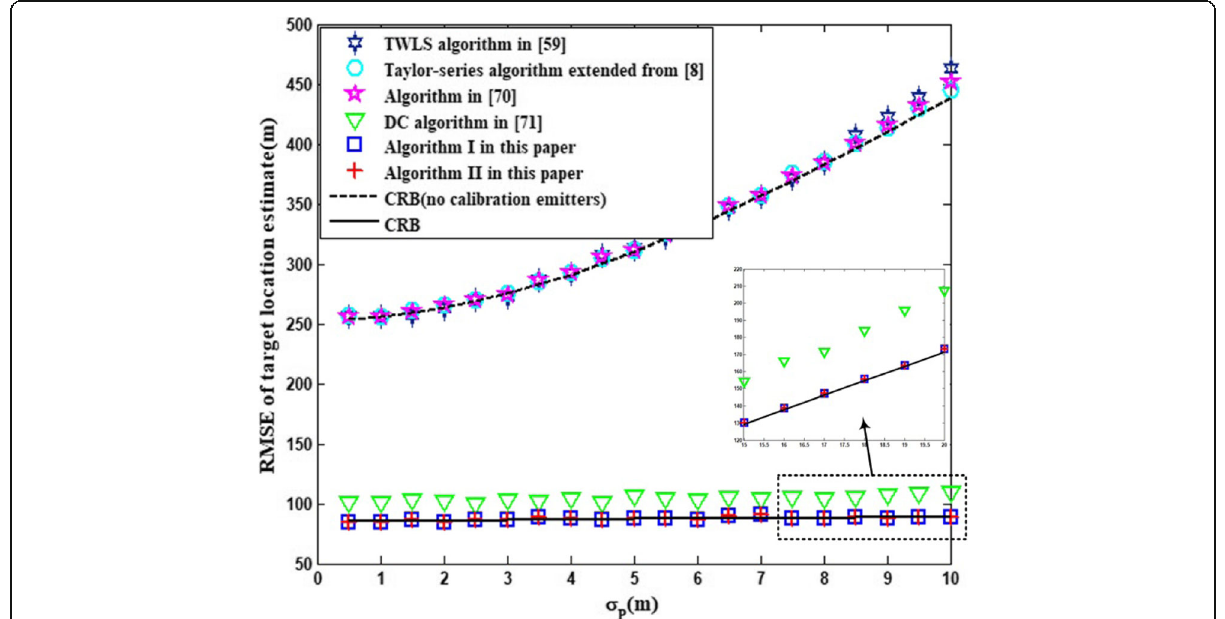
Fig. 9 RMSE of target location estimate versus σ P